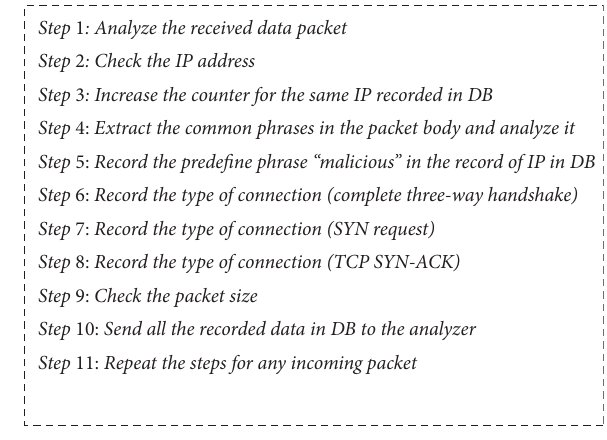
Figure 4: Pseudo code of the proposed algorithm. Table 2: Database of recorded information for each